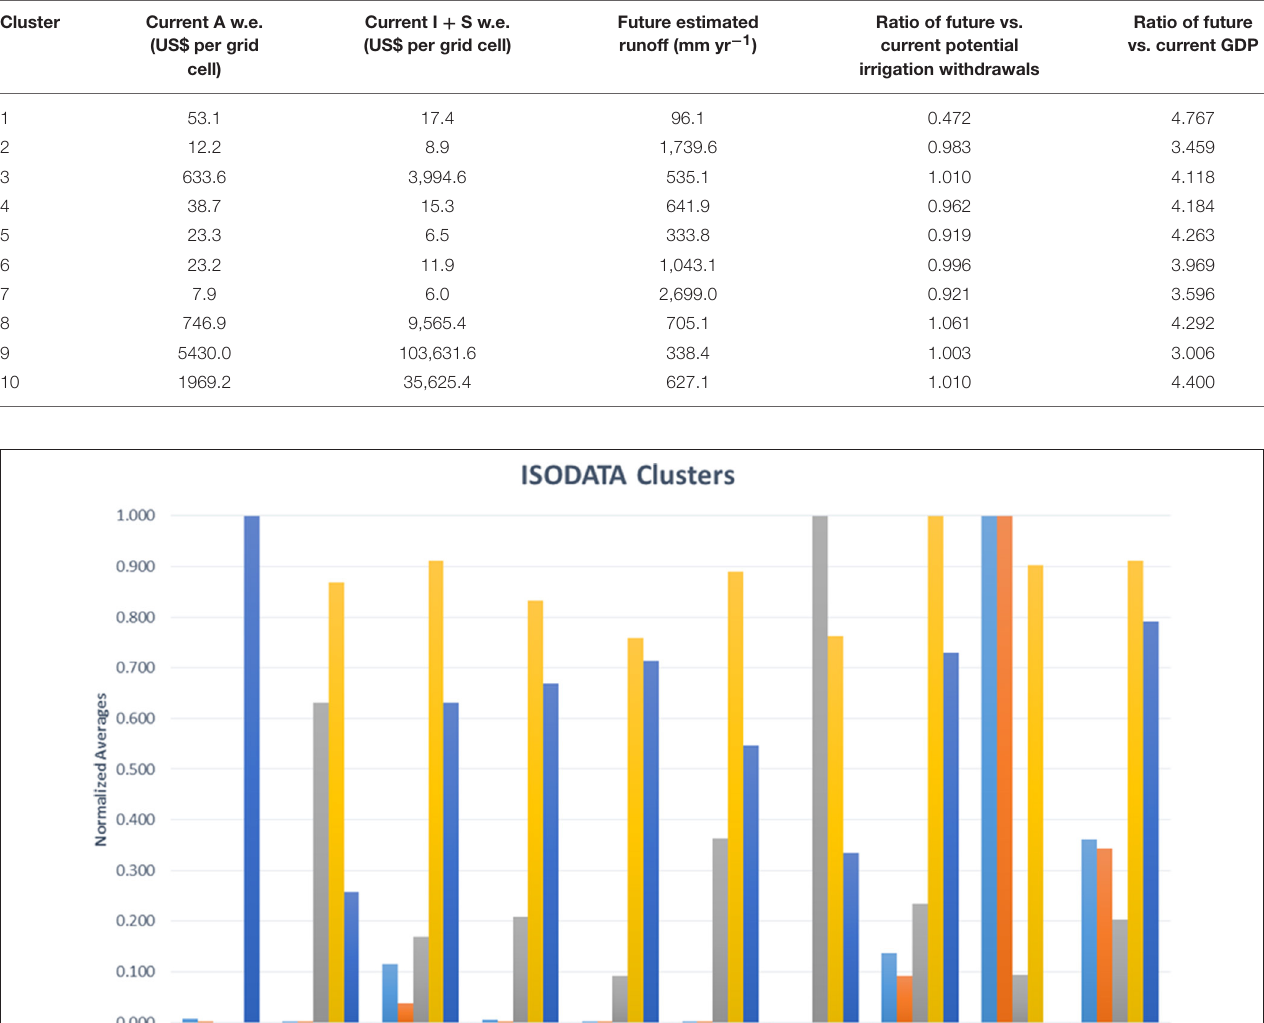
TABLE 5 | Average values of clusters.